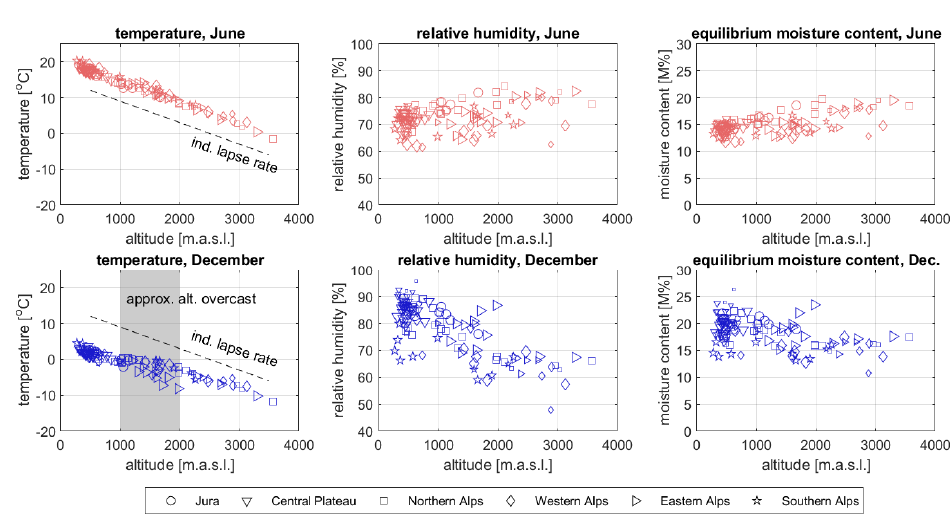
Figure 8. Average relative humidity, temperature, and moisture content from 1990 to 2019, both in June and December. The temperature plots include an indication of the temperature lapse rate and the approximate altitudes of clouds in the winter.